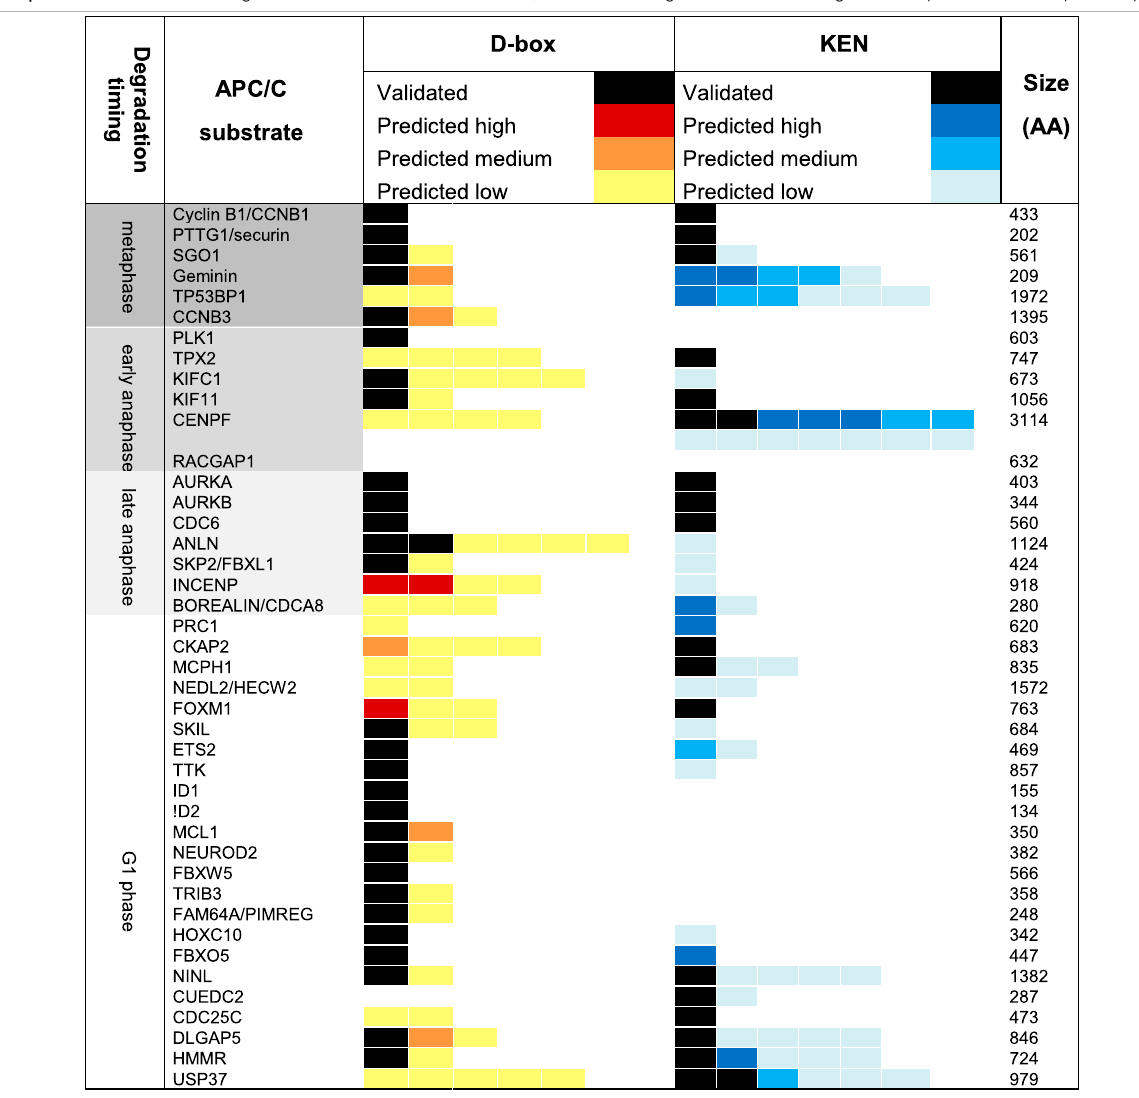
TABLE 1 | Contains information on degrons in well-known APC/C substrates, scored according to the ProVIZ SLI degron tool http://slim.icr.ac.uk/apc/index.php.